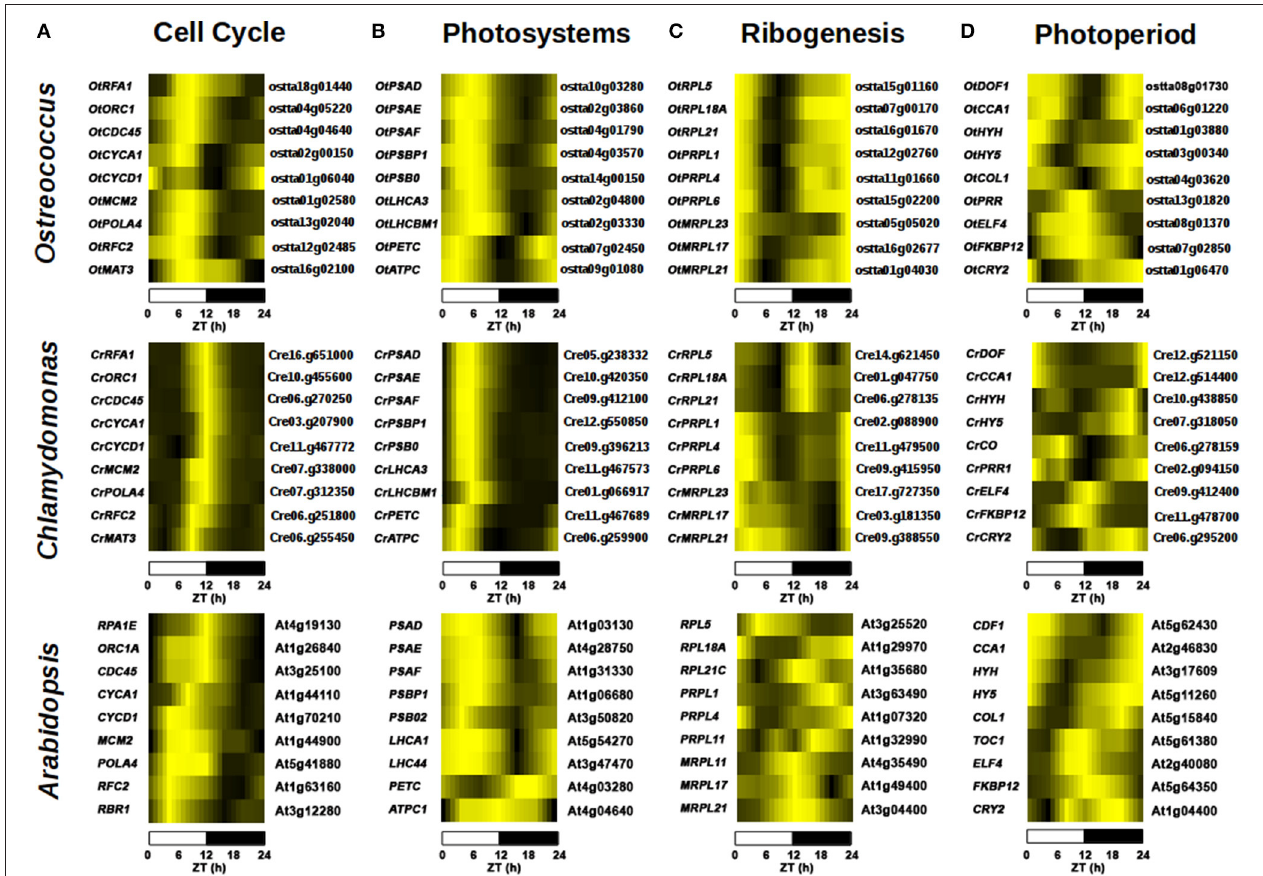
FIGURE 8 | Comparison of gene expression patterns in key biological processes in Chlamydomonas , Ostreococcus and Arabidopsis . Heatmaps are used to represent gene expression with genes sorted according to their expression profile similarity using hierarchical clustering as in Figure 5 . (A) Cell cycle genes such as REPLICATION PROTEIN A ( RPA ) and ORIGIN RECOGNITION COMPLEX 1 ( ORC1 ) exhibit a peak at Dusk and trough at Dawn in the three species. In Ostreococcus and Arabidopsis genes such as DNA POLYMERASE A4 ( POLA4 ) and MINI CHROMOSOME MAINTENANCE 2 ( MCM2 ) are expressed previously to those in Chlamydomonas , presenting broader peaks expanding from Day to Dusk with respect to the narrow peaks at Dusk observed in Chlamydomonas . (B) Photosystem components such as PHOTOSYSTEM I SUBUNIT D ( PSAD ) and PHOTOSYSTEM II SUBUNIT O ( PSBO ) follow similar expression patterns in the three species with peaks at Day and troughs at Night. Only small variations were detected in photosynthesis-involved genes such as the expression profiles of ATP CHLOROPLAST SYNTHASE 1 ( ATPC1 ) and PHOTOSYNTHETIC ELECTRON TRANSFER C ( PETC ). These genes present a peak at Dawn and trough at Dusk in both algae, while in Arabidopsis , ATPC1 is delayed, peaking during the day and PETC anticipates dawn peaking at night. (C) Ribogenesis-involved genes present their peaks at Dawn and troughs at Day in the algae, such as PLASTID RIBOSOMAL PROTEIN L1 ( PRPL1 ) and MITOCHONDRIAL RIBOSOMAL PROTEIN L21 ( MRPL21 ). Cytosolic ribogenesis is uncoupled from organella ribogenesis in Chlamydomonas with genes such as RIBOSOMAL PROTEIN L5 , L21 ( RPL5 , RPL21 ), peaking at Dusk. This uncoupling is not evident in Ostreococcus and no apparent synchronization is observed between genes codifying for ribosome components in Arabidopsis . (D) Photoperiod/circadian central transcriptional regulators exhibit highly similar expression profiles in the three species. DOF , CCA1, and COL present the same expression pattern; peaking at Dawn with their troughs at Dusk. Some genes, such as OtPRR and TOC1 , present very similar profiles (peaking at Dusk with their troughs at Dawn) in Ostreococcus and Arabidopsis , whereas in Chlamydomonas CrPRR follows a symmetric pattern peaking at Dawn and a trough at